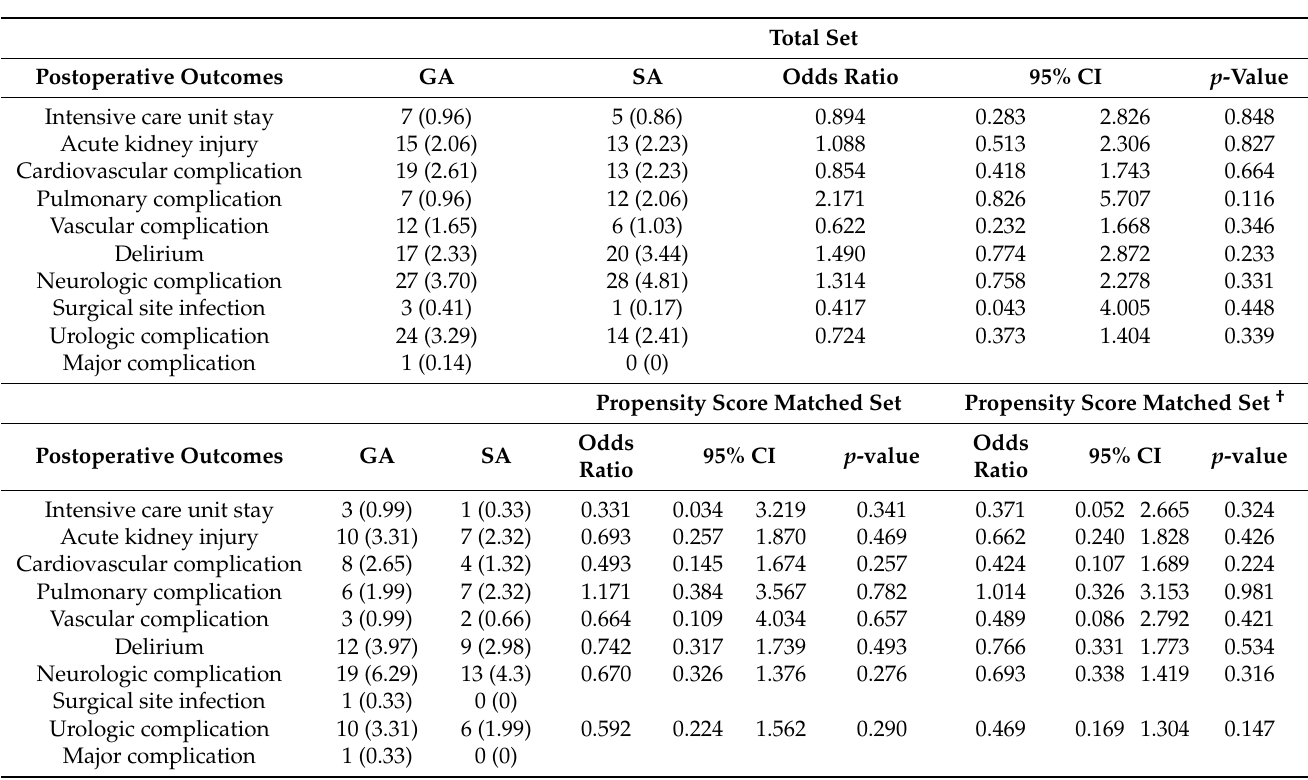
Table 4. Odds ratios for postoperative